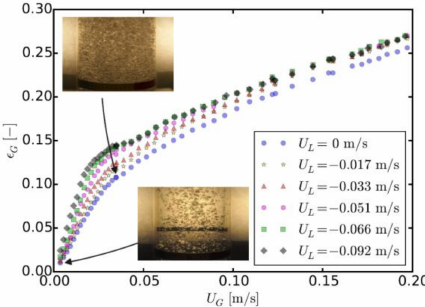
Figure 18. Spider sparger—data from ref.